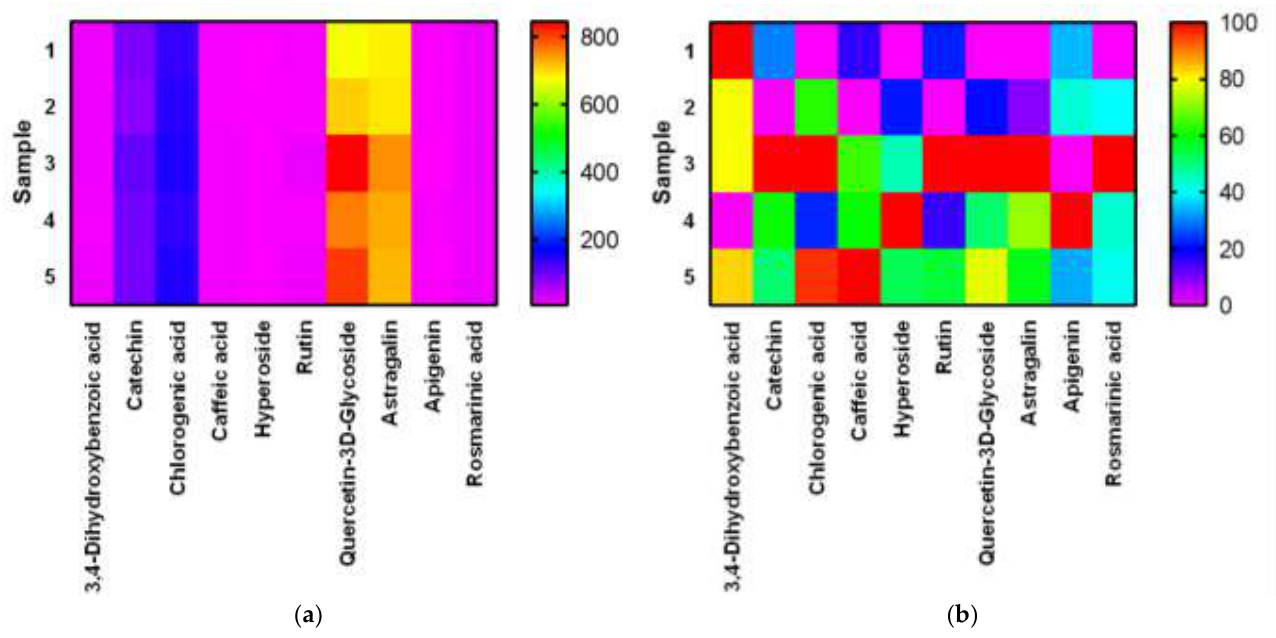
Figure 8. Heatmap for BAS content E. globulus extract with different extraction times (with US treatment): ( a ) — native data, ( b ) — after normalized.